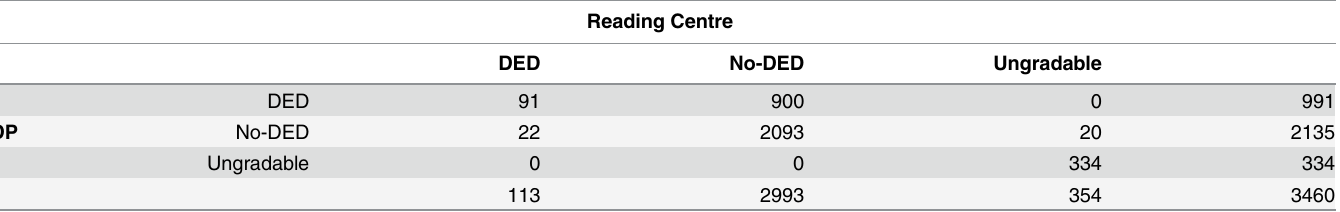
Table 2. Results — Comparison of the grading of DED from the IDP and the Reading Centre.